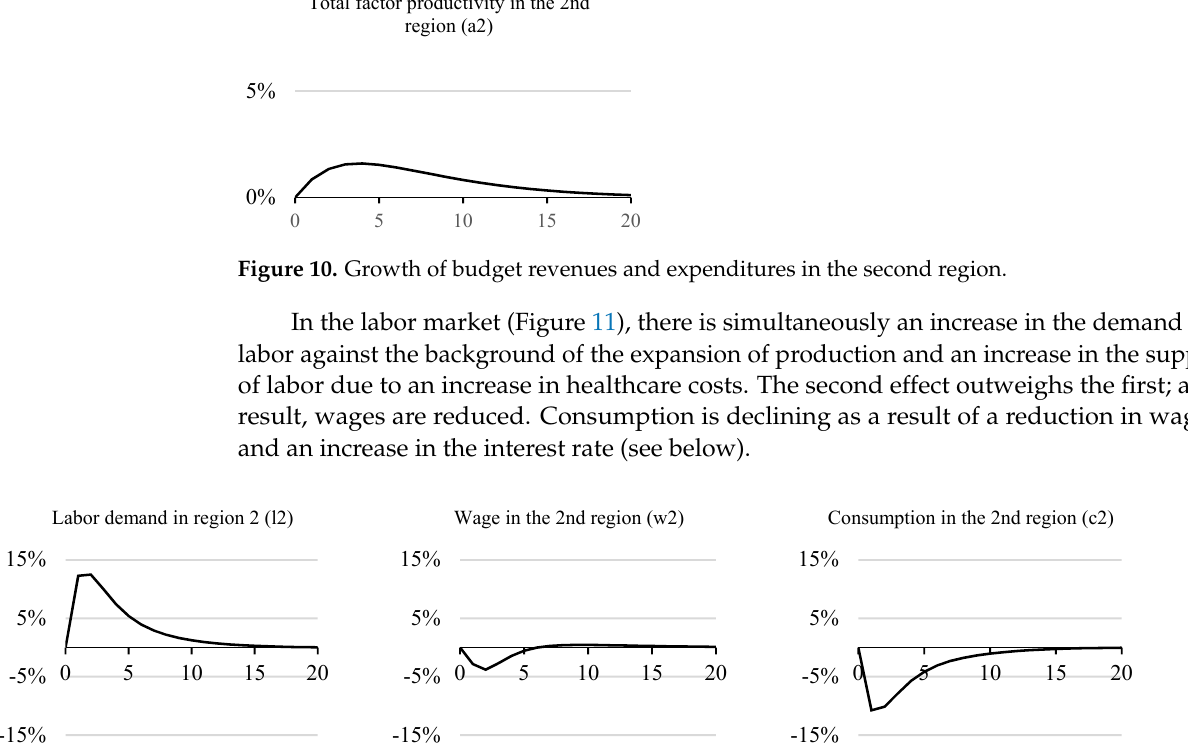
Figure 9. Growth of budget revenues and expenditures in the second region. The growth of current budget purchases reinforces the positive output gap. Moreo- ver, the growth of human capital expenditures raises the aggregate factor productivity (Figure 10).